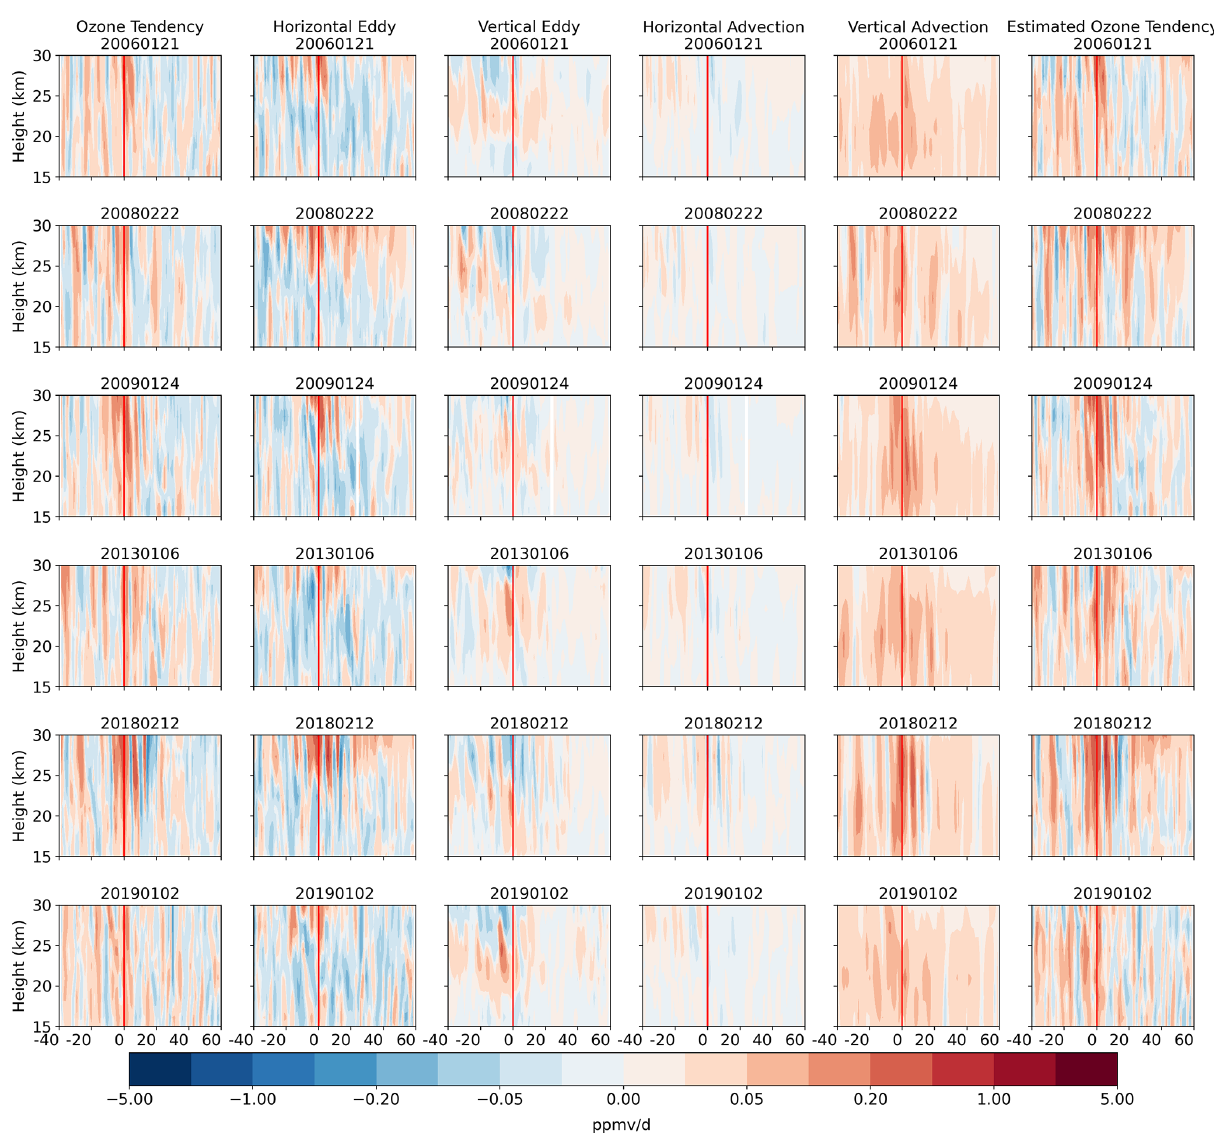
Figure 11. Same as Fig. 8 for ozone tendency, horizontal and vertical component of eddy mixing, horizontal ( − v ∗ x y ) and vertical ( − w ∗ x z ) component of mean advection, and the indirect ozone tendency using the right-hand side of Eq. (2). Summing four middle columns leads to the estimated ozone tendency on the sixth column. The vertical axis is the log-pressure